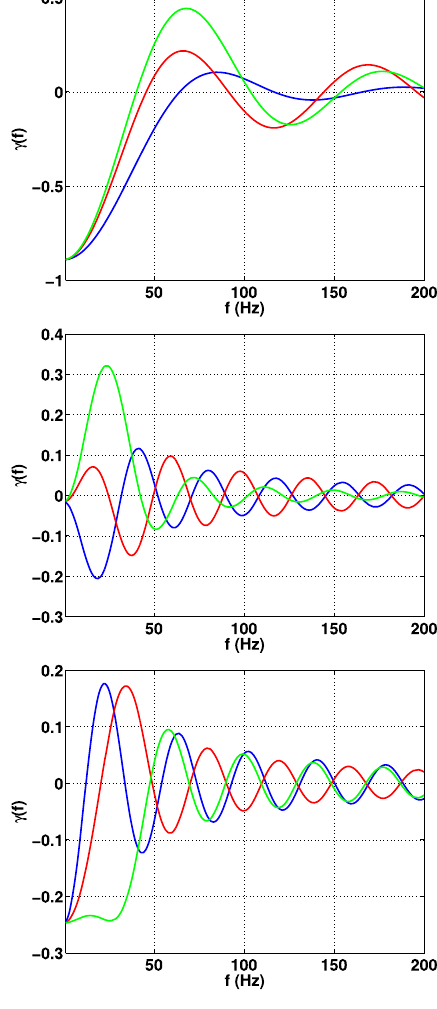
Fig. 66 Normalized overlap functions for unpolarized tensor, vector, and scalar modes for the LIGO Hanford-LIGO Livingston detector pair ( top panel ); for the LIGO Hanford-Virgo detector pair ( middle panel ); and for the LIGO Livingston-Virgo detector pair ( bottom panel ). The tensor overlap functions are shown in blue ; the vector overlap functions are shown in red ; the scalar overlap functions are shown in green . These overlap functions were calculated in